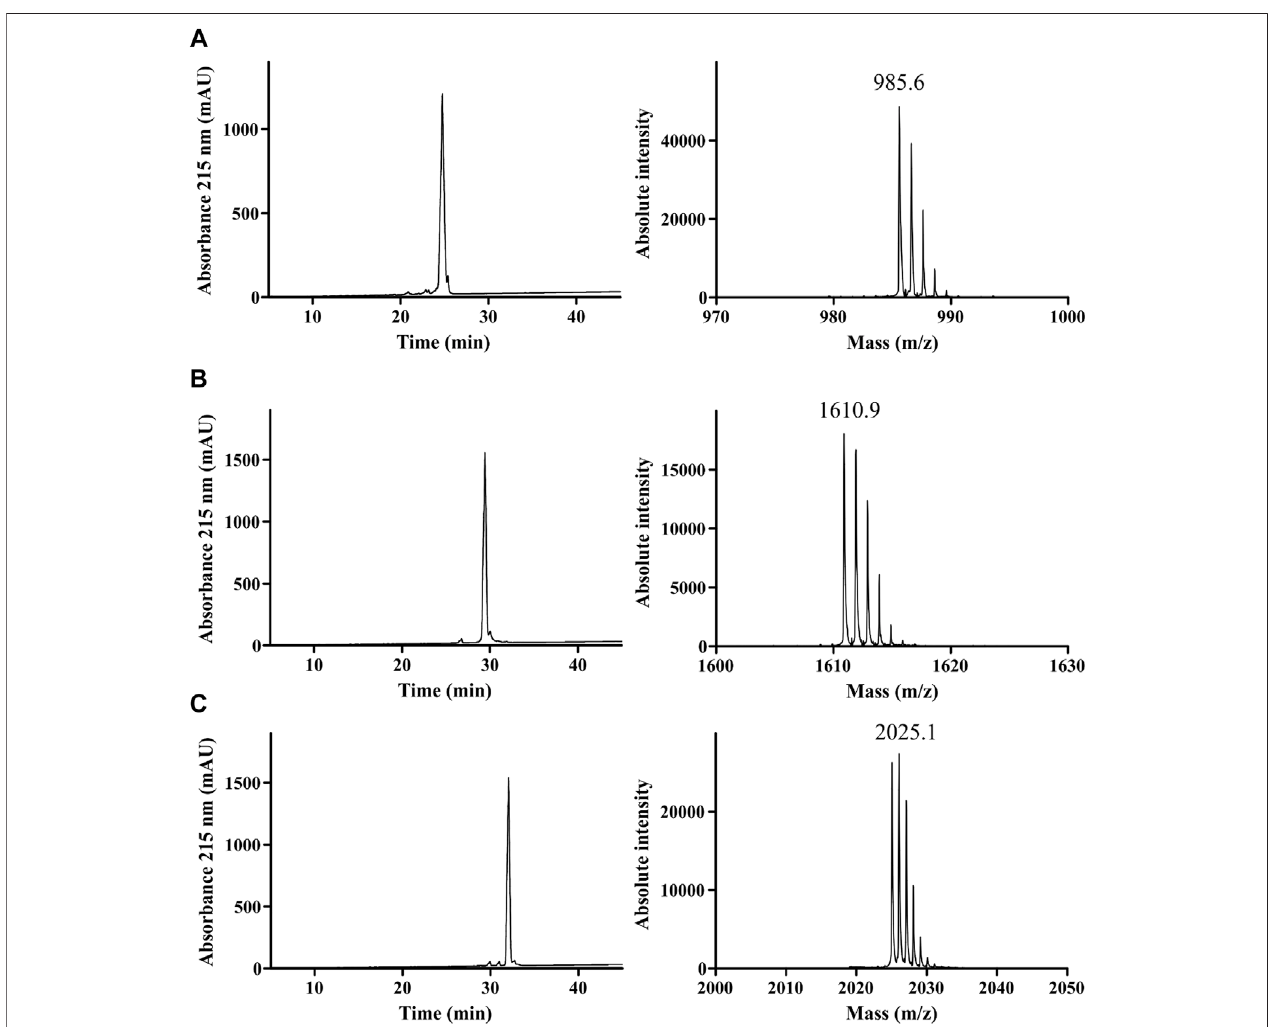
FIGURE2| Qualitycontrolofsynthesized blenniorphins.HPLC pro fi les(left) and MALDI massspectra(right) of (A) blenniorphin 1 – 8, (B) blenniorphin 1 – 13and (C) blenniorphin 1 – 17. Shown are monoisotopic [M + H] + masses of peptides. The A215 chromatograms indicates a purity of > 95%.